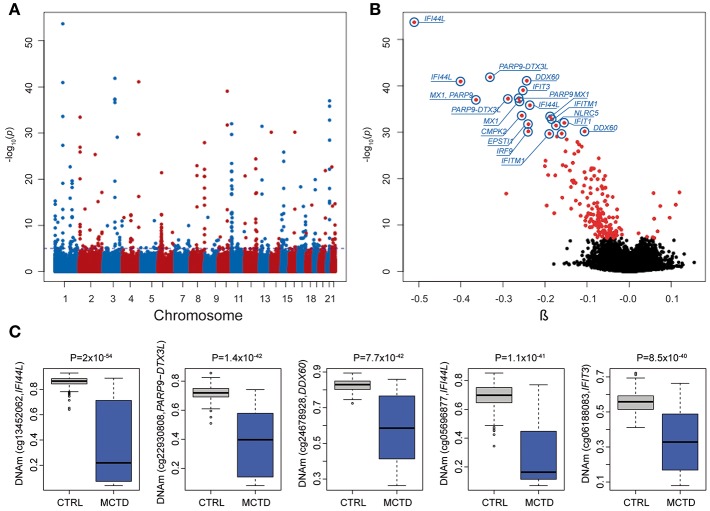
Results from epigenome-wide association study (EWAS) in mixed connective tissue disease. (A) Manhattan plot showing the EWAS results. P-values are represented on the –log10 scale in the y-axis. The genomic position for each CpG tested is represented in the x-axis. Discontinuous blue line represents the genome-wide significance threshold (P < 6.4 × 10−08). The top 10 associations are labeled with gene names. (B) Volcano plot of the EWAS results. P-values are represented on the –log10 scale in the y-axis. The effect size and direction of obtained in EWAS result for each CpG site is depicted in the x-axis. Red dots represent significant associations. The top 10 associations are labeled with gene names. (C) Boxplot representing the top five differentially methylated CpG-sites in cases and healthy controls. DNAm levels are presented in the y-axis. Horizontal line is the boxplot corresponds to the median DNAm levels for each group.